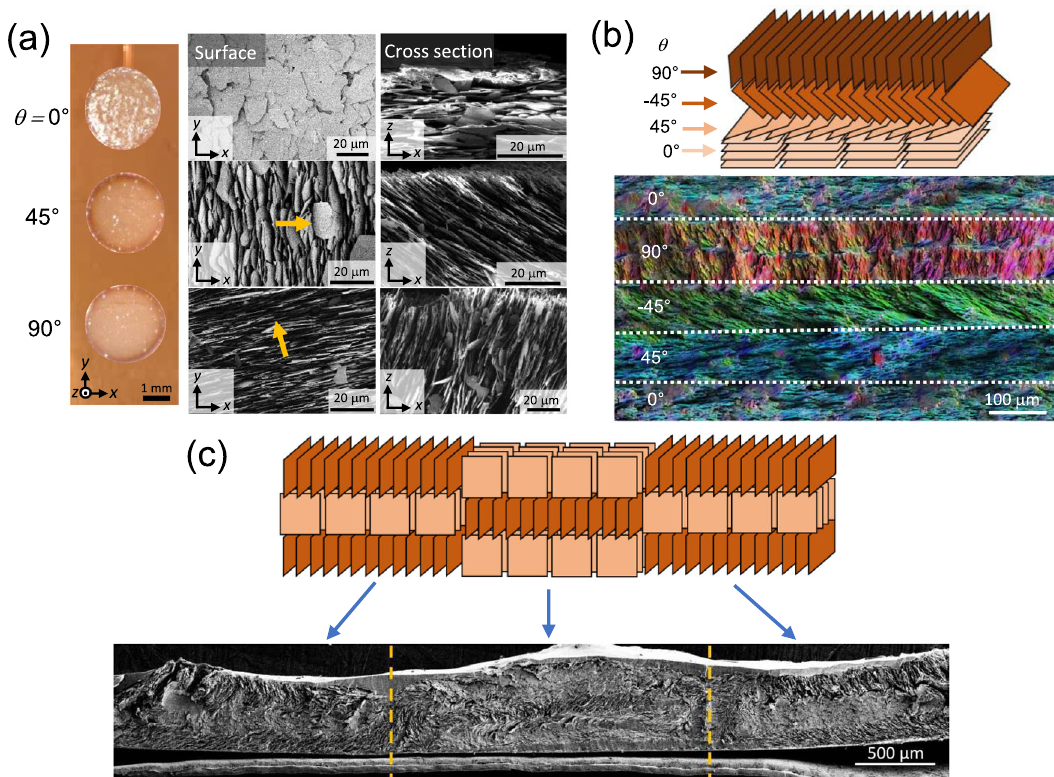
Fig. 4 | Printing voxelated microstructures using the optimised xirallic ink on copper. a Optical imagesof printed aligned droplets with microplatelet alignment at different angles θ . The electron micrographs show the surface morphology (middle) and cross-section (right) of the corresponding droplets. The orange arrows on the surface morphology images represent the normal vector of the platelets which is indicative of their lateral directions. b Schematic of a multilayer structurewithvaryingplateletangles θ ineachlayerandtheelectronmicrographof